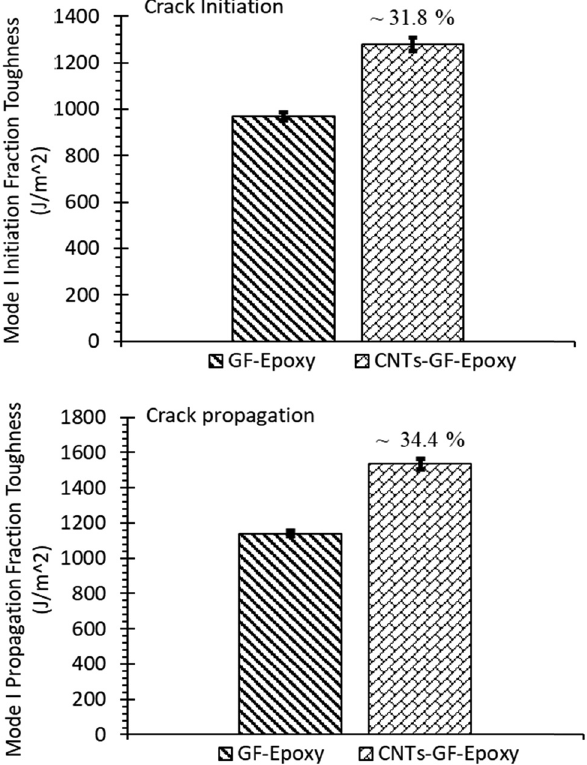
Figure 10: Comparison of the crack initiation and propagation frac - ture toughness for control sample ( GF - Epoxy ) and hybrid sample ( CNTs - GF - Epoxy ) .